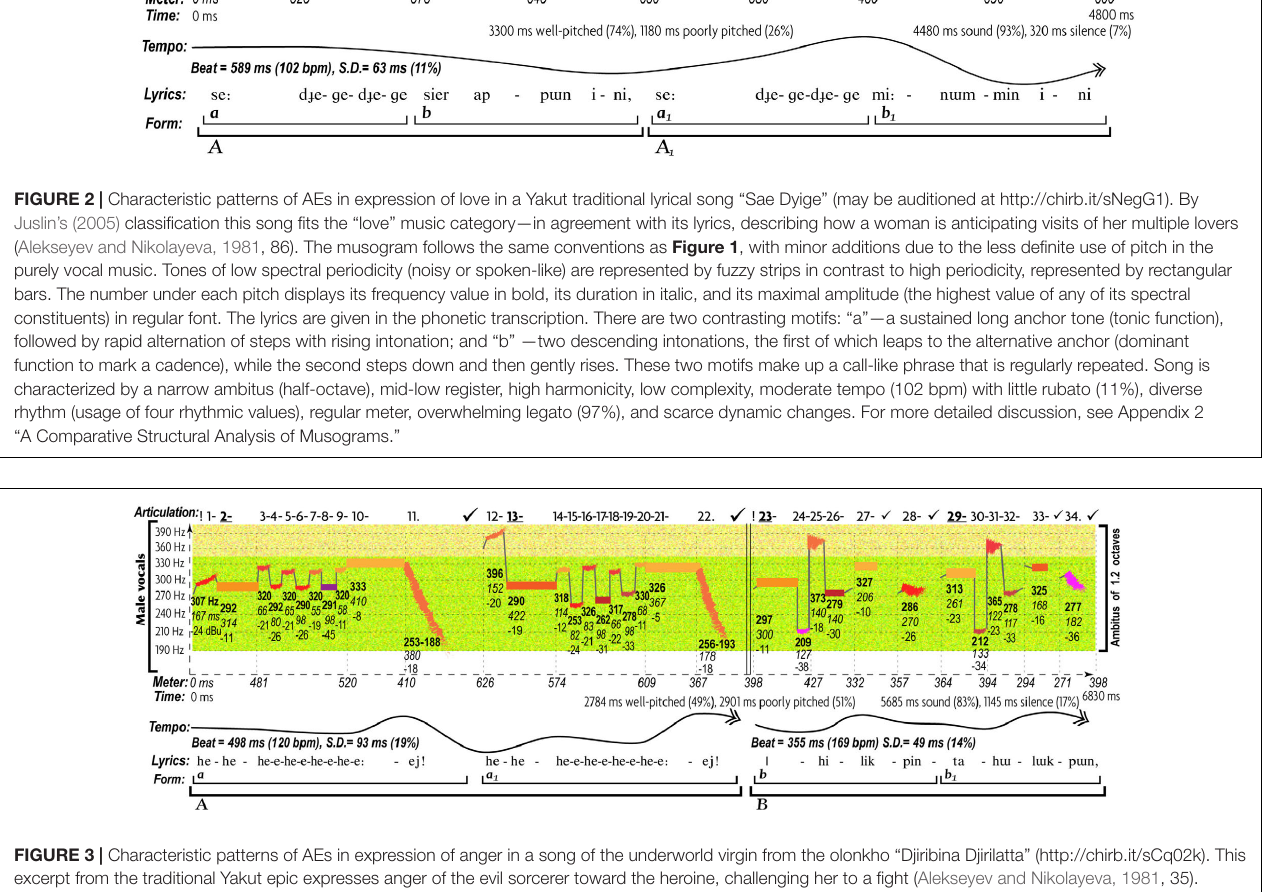
prompts the cross-examination of the cries’ acoustic